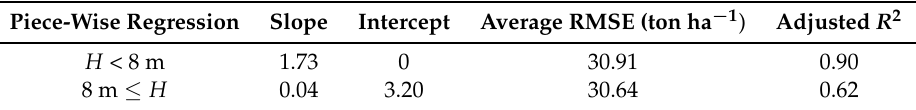
Table 5. The slope and intercept of piece-wise linear regression for the RMoG L model. Piece-Wise